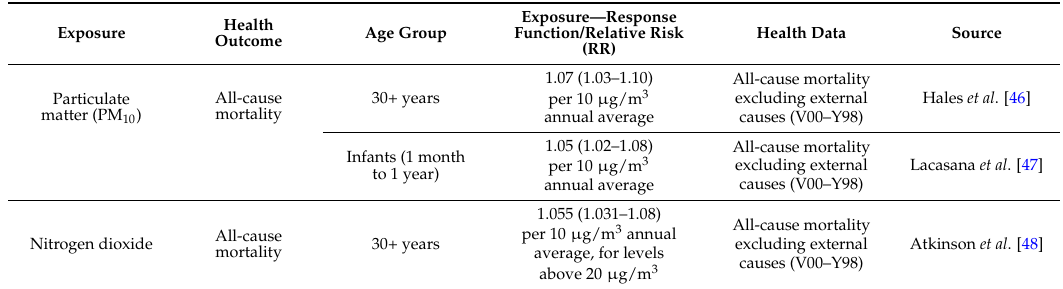
Table 1. Exposure-response functions for selected health effects from road